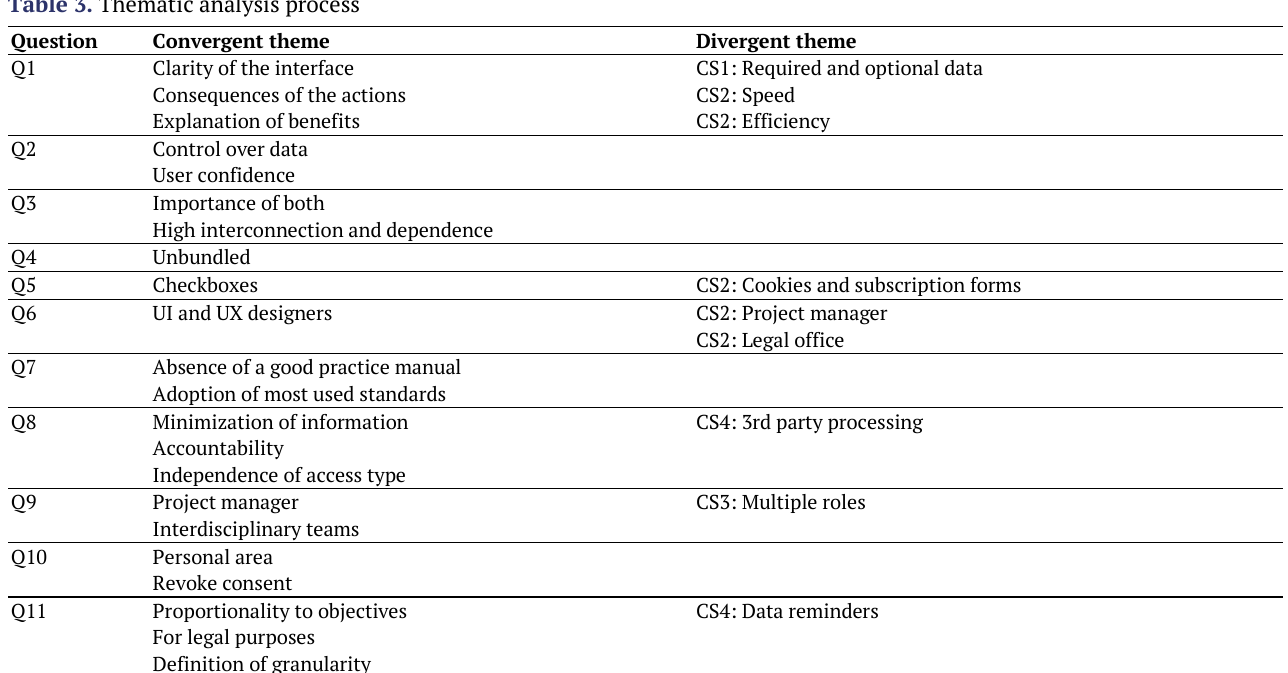
Table 3. Thematic analysis